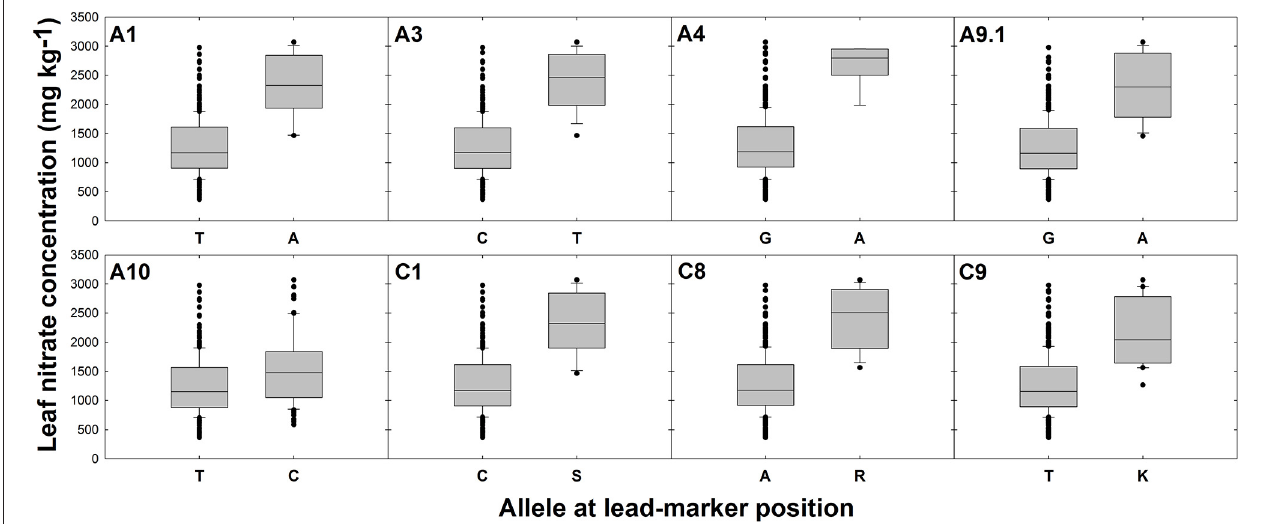
FIGURE 3 | Effects of reference allele and most frequent allelic variant at lead-marker loci on leaf nitrate concentration. Each panel refers to a specific association peak; lead-markers at each peak are listed in table 1. Boxes represent the mid two quartiles with the median drawn; whiskers above and below the boxes indicate the 90 and 10th percentiles with any outliers shown. A, T, G, and C alleles represent adenine, thymine, guanine and cytosine nucleotide calls, respectively. S, R, and K alleles represent Strong (C or G), purine (A or G) or Keto (C or T) nucleotide calls, respectively, thus called due to unresolvable variation in closely related genes. Differences in leaf nitrate concentration between alleles at each loci significant at p < 0.001.